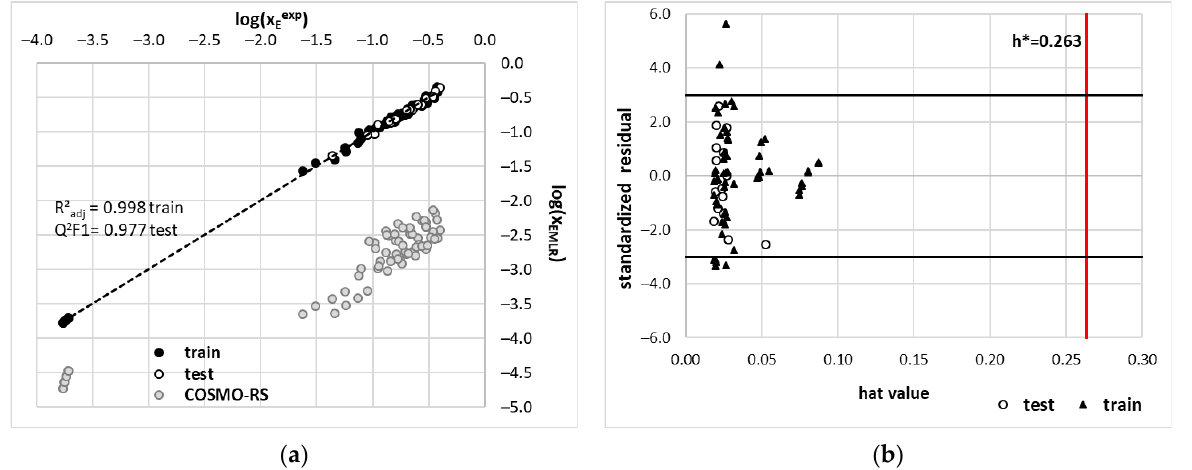
Figure 11. The results of the best MLR model applied for solubility computations of edaravone in studied DES. ( a ) computed solubility confronted with experimental values; ( b ) applicability domain characteristics of the model defined by Equation (1). The symbol h* defines the maximal hat values and is computed as follows h*=3 · (k-1)/N, where k stands for the number of parameters (k=6) and N is the number of data points in the training set (N=57).